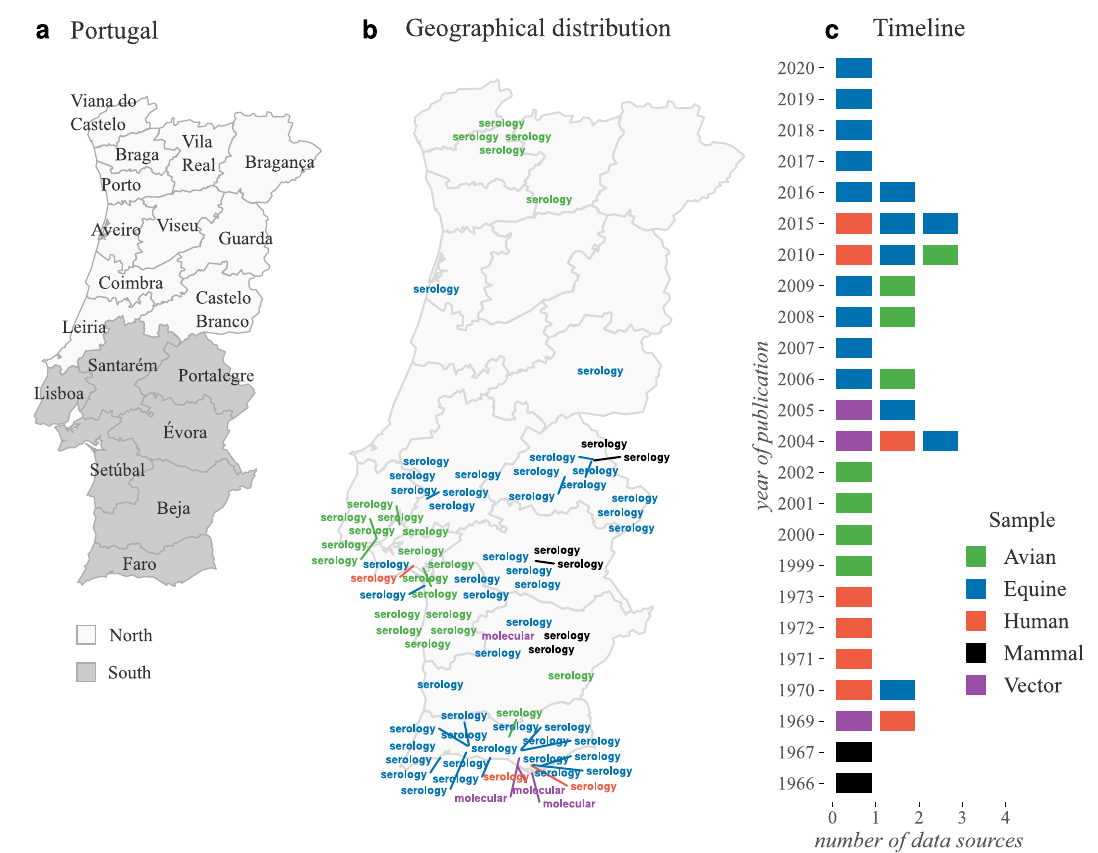
Fig. 1 Past evidence of WNV circulation in Portugal. Summary of data sources (articles, national reports) on various types of evidence for the circulation of WNV in Portugal. a presents the of fi cial (district) divisions of Portugal, colored according to north and south areas. b presents the geographical region of each data source (latitude-longitude). Positioning is only approximate, given that some reports refer to regions of different areas. For data sources referring to large areas (e.g. districts), the capital city of the region was used. Not all sources are mapped, e.g. not reporting where positive samples were found. Mapped words represent the type of evidence reported, aggregated into two categories: molecular, for PCR, isolation; and serology, for HI, VNT, ELISA. c shows a timeline of the number of data sources per year. The color scale (on the right) represents the different types of samples reported, and refers to both panels b and c . Not all years between 1966 and 2020 had data sources. A detailed summary of data sources in Supplementary Table